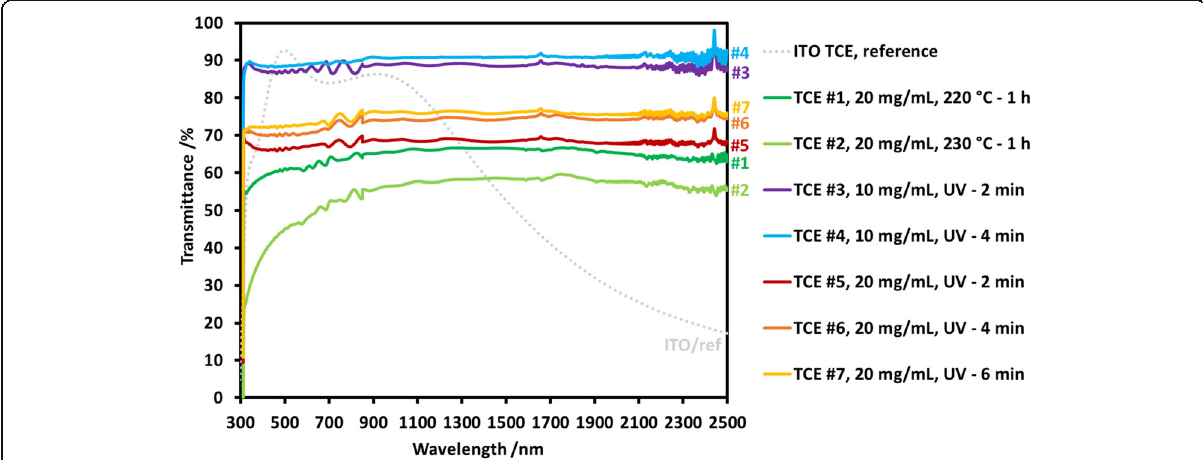
Fig. 5 UV-Vis/NIR transmittance spectra between 300 and 2500 nm: they correspond to a commercial, glass-supported ITO TCE and to either thermally or UV-treated, PET-supported Cu NW